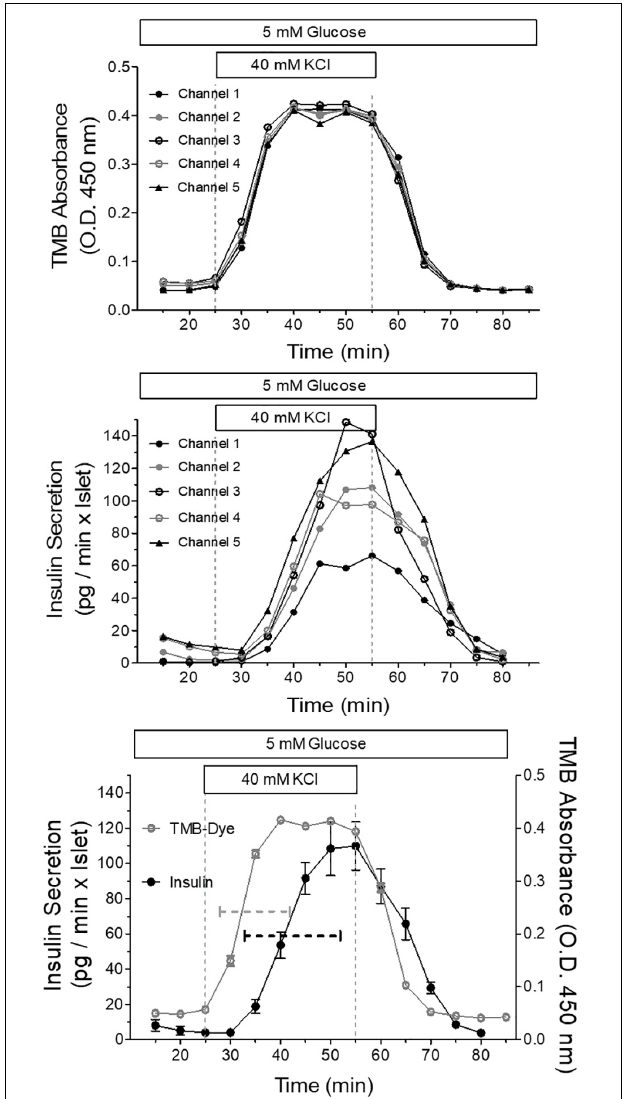
FIGURE 11 | Relation between the stimulus pattern and the secretory response of parallel perifused islets in the microfluidic system. Five islets of similar size were placed in the wells, one each per well, and perifused with KR medium. The efflux of the medium was collected by a 96 well plate and the insulin content of the fractions was determined by ultrasensitive ELISA. From 25 to 55 min the islets were stimulated with 40mM KCl. This experiment was conducted at 37 ◦ C and each channel was perfused at a rate of 20 µ l/min. Shown are the curves of five independently dye (TMB)-perfused channels to visualize the square wave stimulation by KCl (upper panel) and the secretion curves of five independently perifused islets responding to the square wave-stimulus (middle panel). The respective mean values ± SEM of secretion (closed circles) and dye perfusion (open circles) are depicted in the lower panel. The dashed lines indicate the time required from the onset of increase until steady state. When no SEM range is visible, it is smaller than the symbol